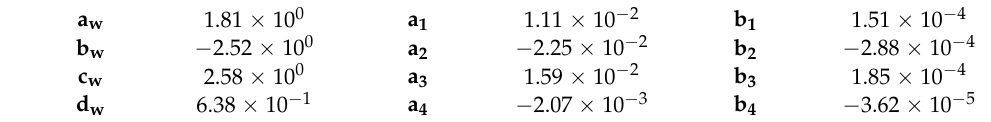
Table A37. Coefficients of the CH 3 OH-LiBr specific heat